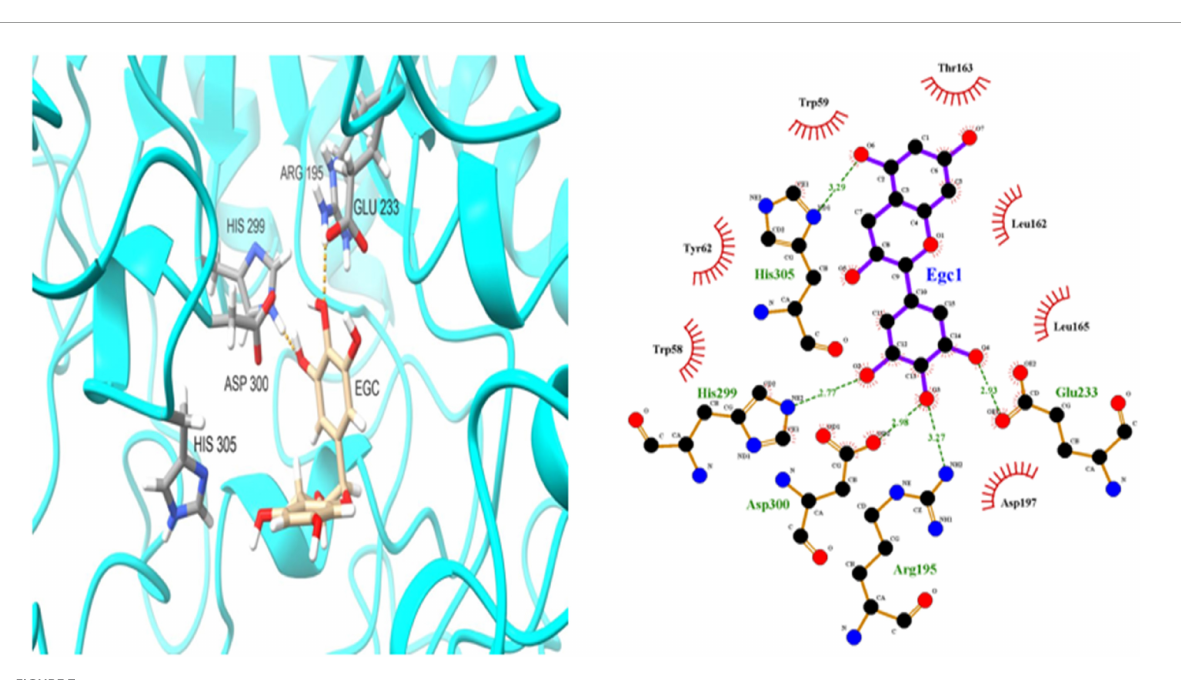
gradually decreased, and the maximum emission wavelength red-shift slightly, making α -amylase’s change more obvious. This concentration-dependent relationship showed EGC’s interaction with α -glucosidase and α -amylase (47). The red